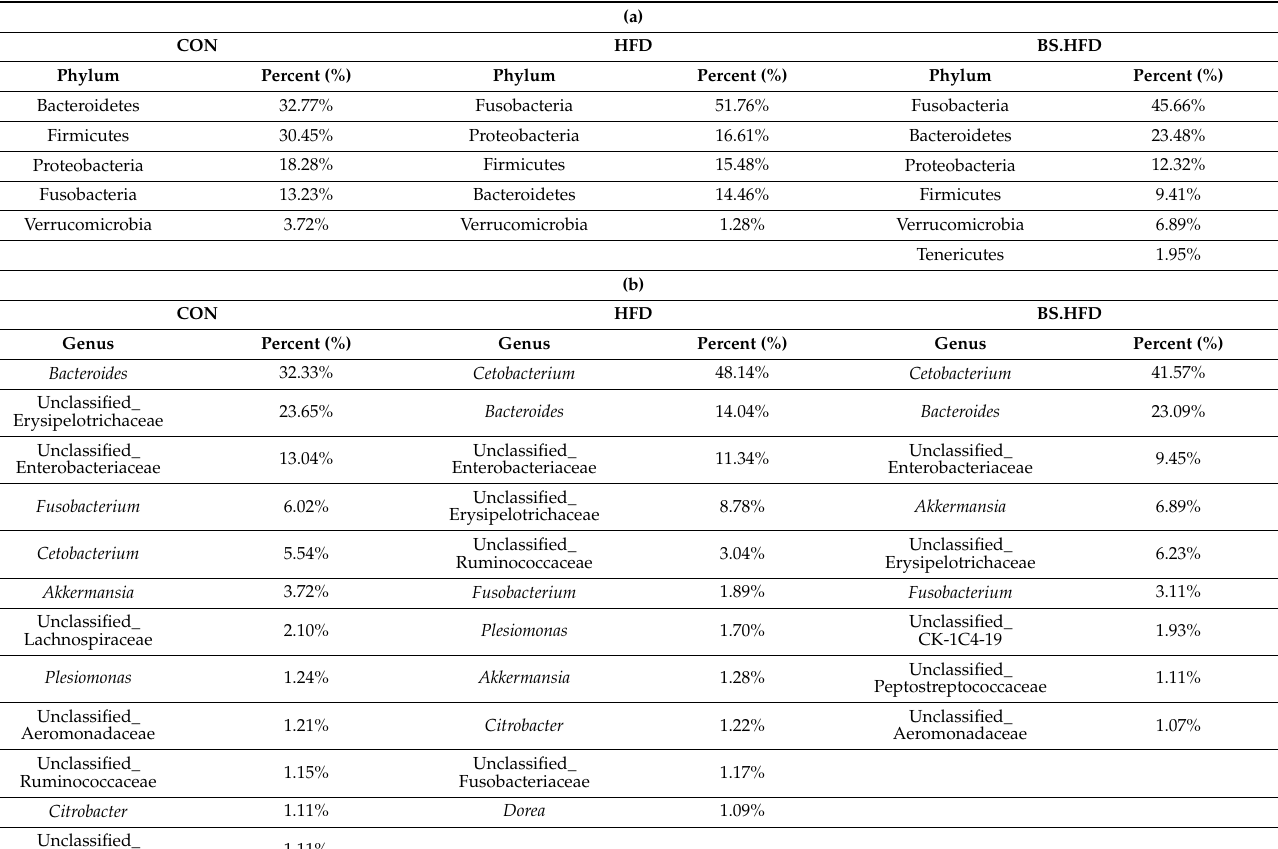
Table 5. ( a ) Relative abundance of bacteria in the intestinal microbiota of C. idella at the phylum level; ( b ) The relative abundance of bacteria in the intestinal microbiota of C. idella at the genus level.